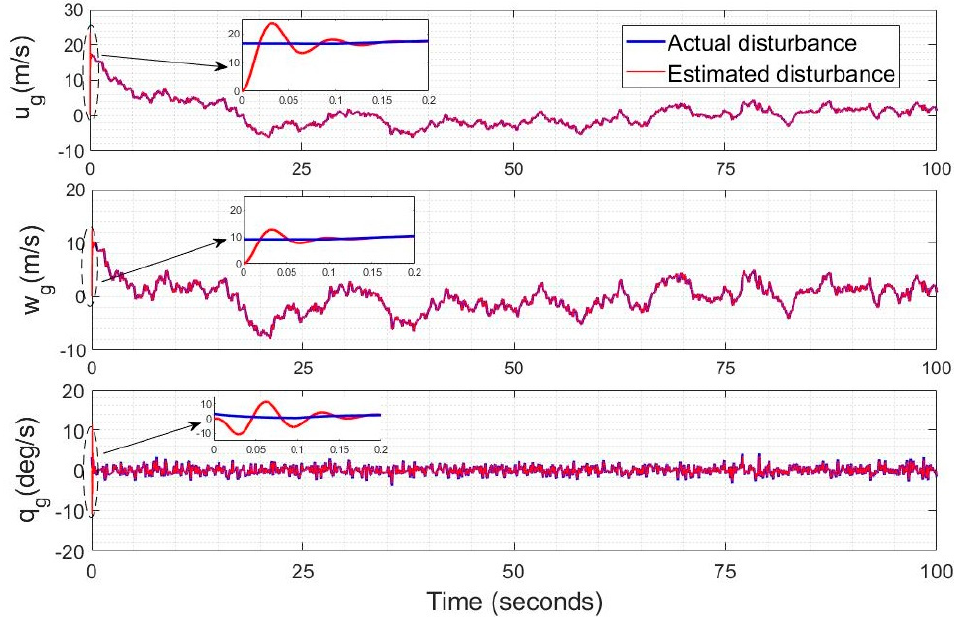
Figure 5. Wind perturbation estimation using the unknown input observer.